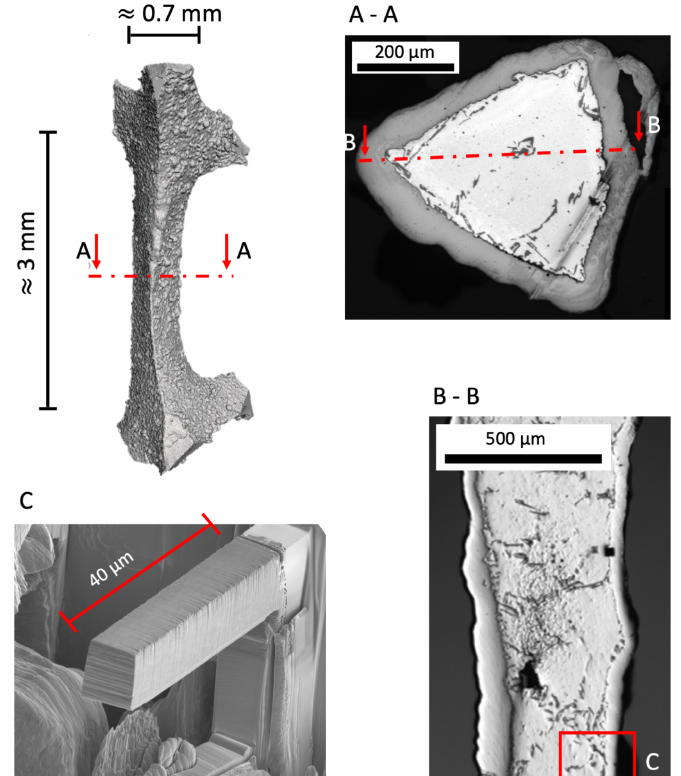
Figure 5. Positioning of microbending beam at the interface. The capital letters A and B indicate the location of the corresponding cross sections in the following sectional views A-A and B-B